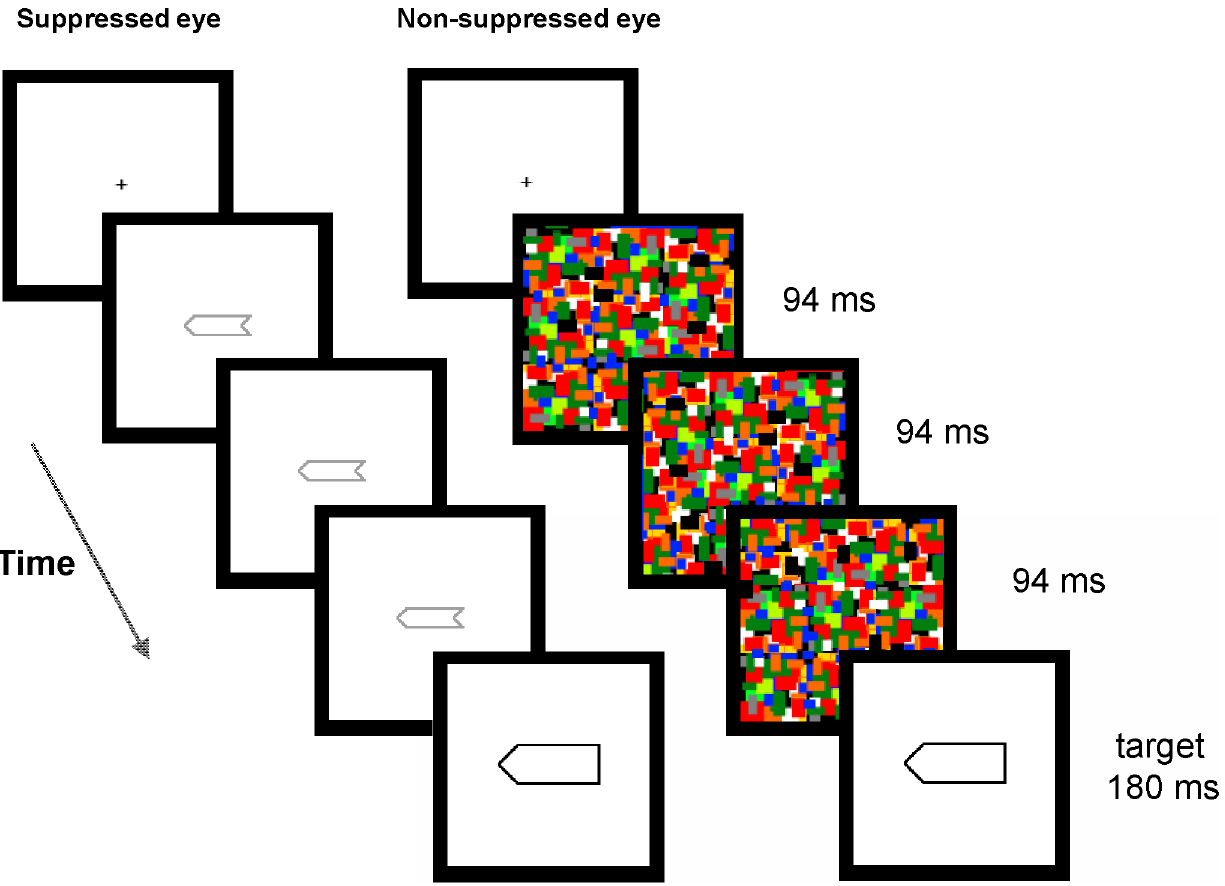
Fig 1. Stimuli and procedure. The sequence of stimulation in the 282 ms stimulus-onset asynchrony/prime duration condition. The participants responded to the orientation of the target and then rated the visibility of the prime and made a forced-choice response to the orientation of the prime.